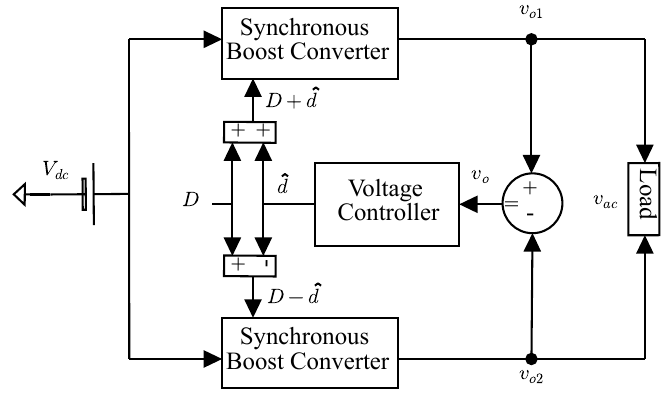
Figure 14. Top view of the overall